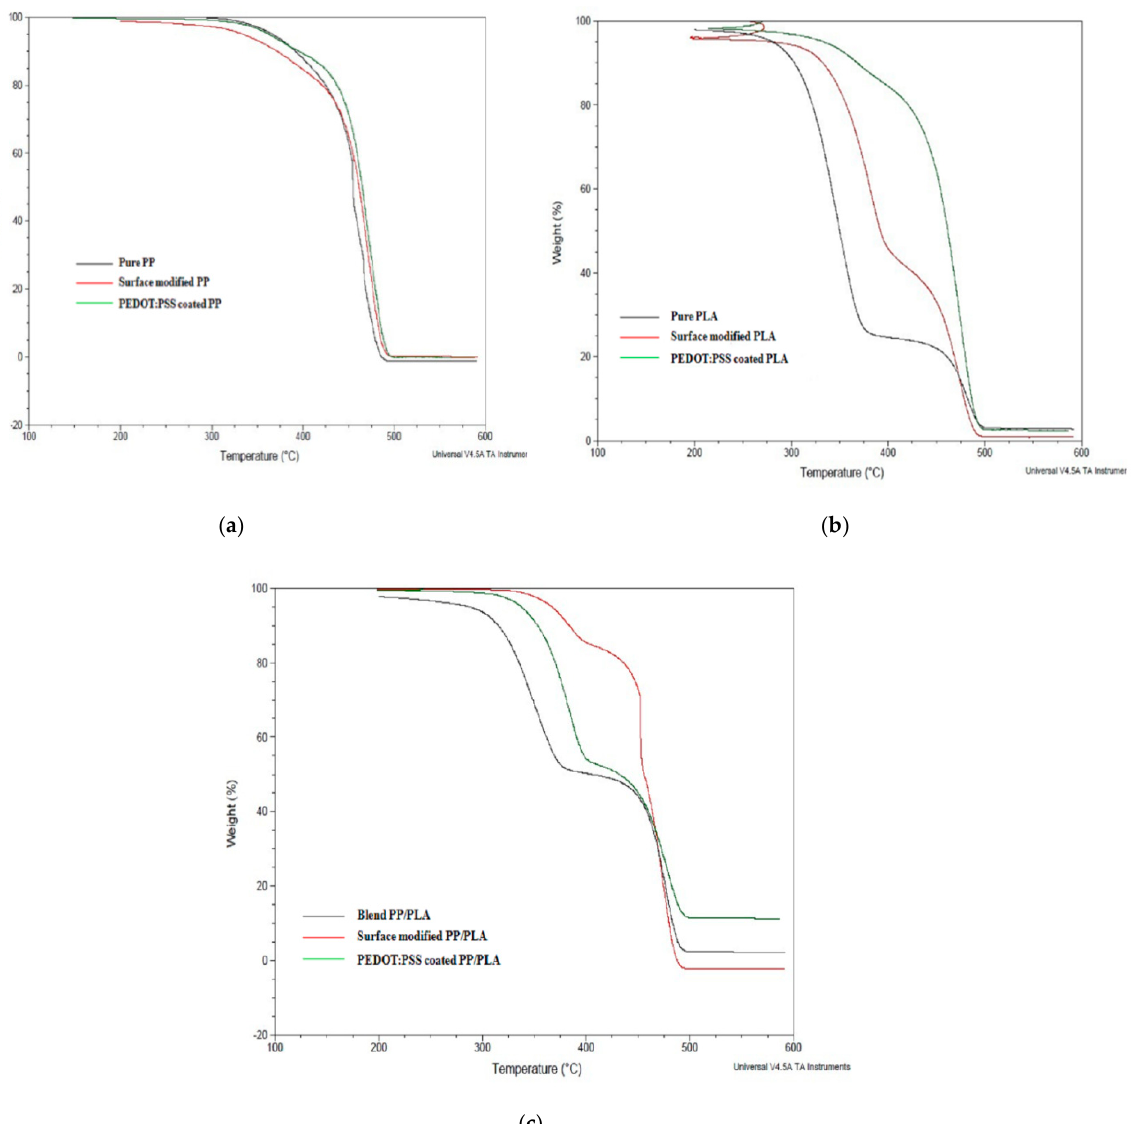
Figure 12. Thermogravimetric analysis (TGA) of PDA treated and PEDOT:PSS coated ( a ) PP, ( b ) PLA and ( c ) PP/PLA yarn.